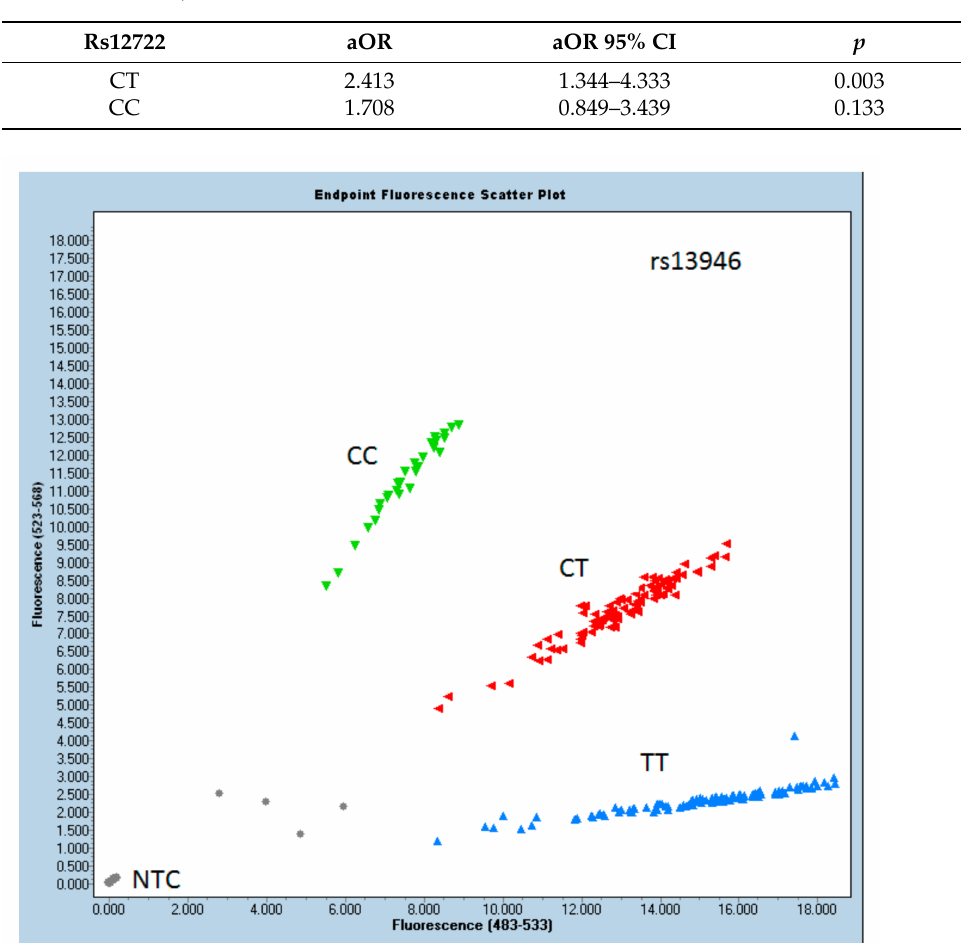
Table 3. Logistic regression modeling using stepwise backward validation (model’s R2 Nagelkerke’s estimation = 0.075).